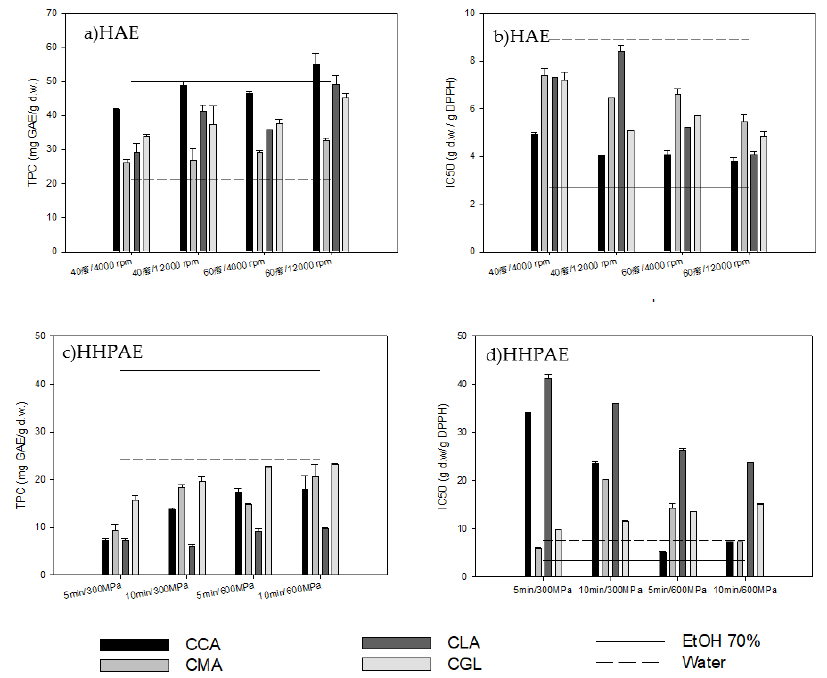
Figure 2. Effect of extraction temperature and NADES type on total phenolic content (TPC) ( a , c ) and antioxidant activity (IC50) ( b , d ) of olive leaf extracts by homogenate-assisted extraction (HAE) and high hydrostatic pressure-assisted extraction (HHPAE), respectively.